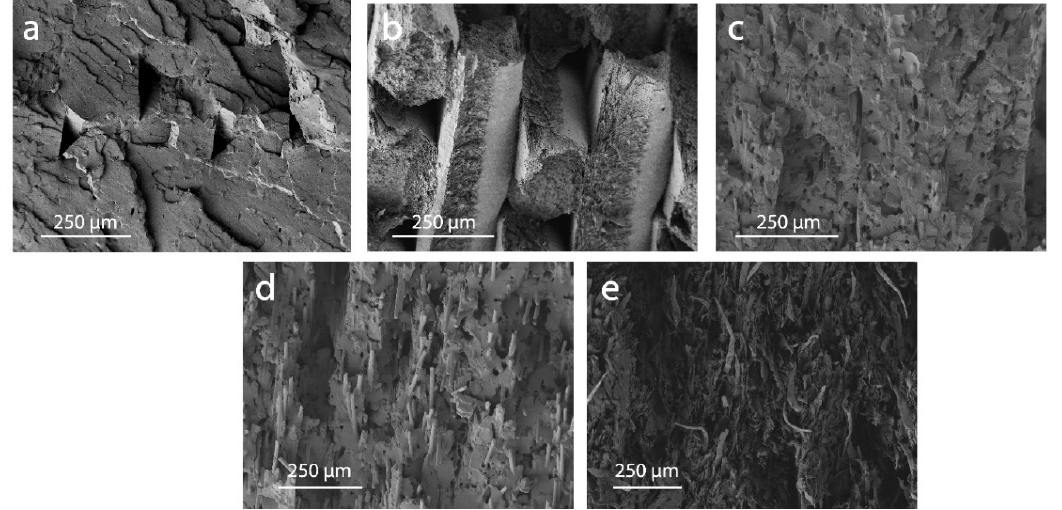
Figure 8. Example of fractured surfaces as obtained after tensile tests observed by SEM for ( a ) neat polymeric matrices and the respective composites, ( b ) Udiam-PLA, ( c ) CF-PET, ( d ) GF-PA6 and ( e ) UPM Formi-PLA.